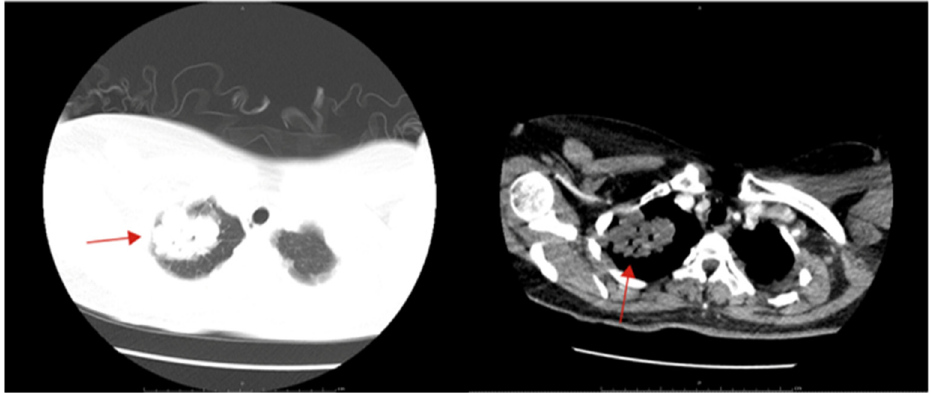
Figure 1. Chest CT showed a mass in the right upper lung (solid red